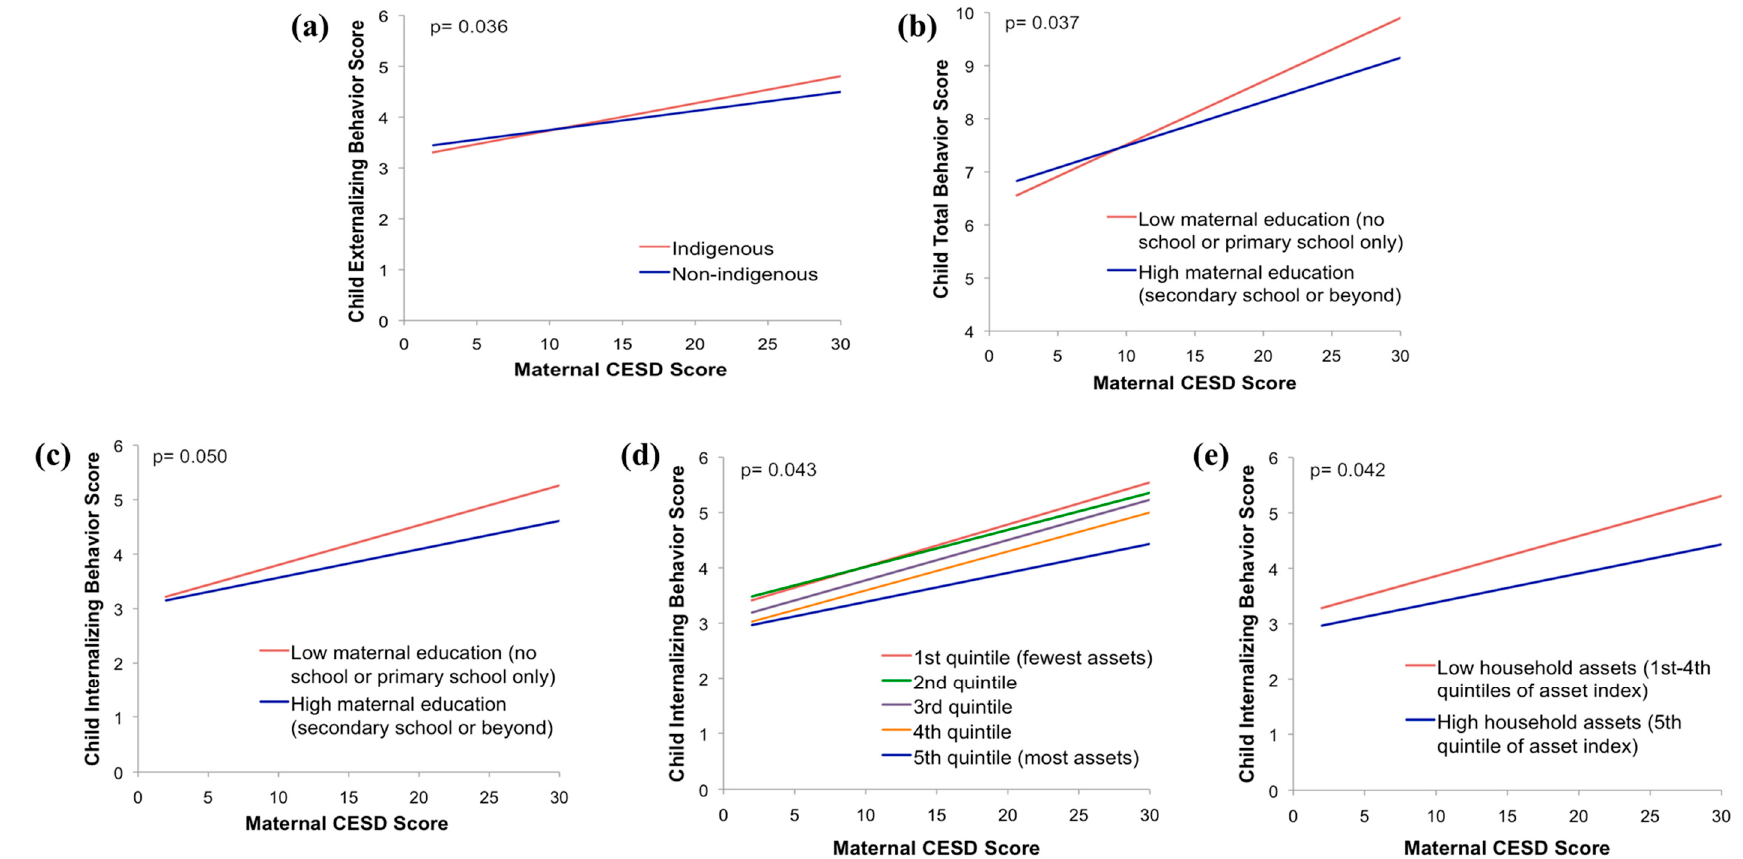
Figure 1. Two-way interaction effects were examined with total maternal CES-D score and ( a ) Ethnicity and child externalizing behavior score; ( b ) Maternal education and child total behavior score; ( c ) Maternal education and child internalizing behavior score; ( d ) Asset index quintiles and child internalizing behavior score; ( e ) Asset index and child internalizing behavior score. The five interactions depicted here were statistically significant at p ≤ 0.05 in unadjusted models.